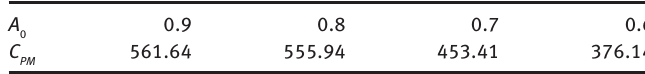
Table 3: PM Cost for Different Values of A